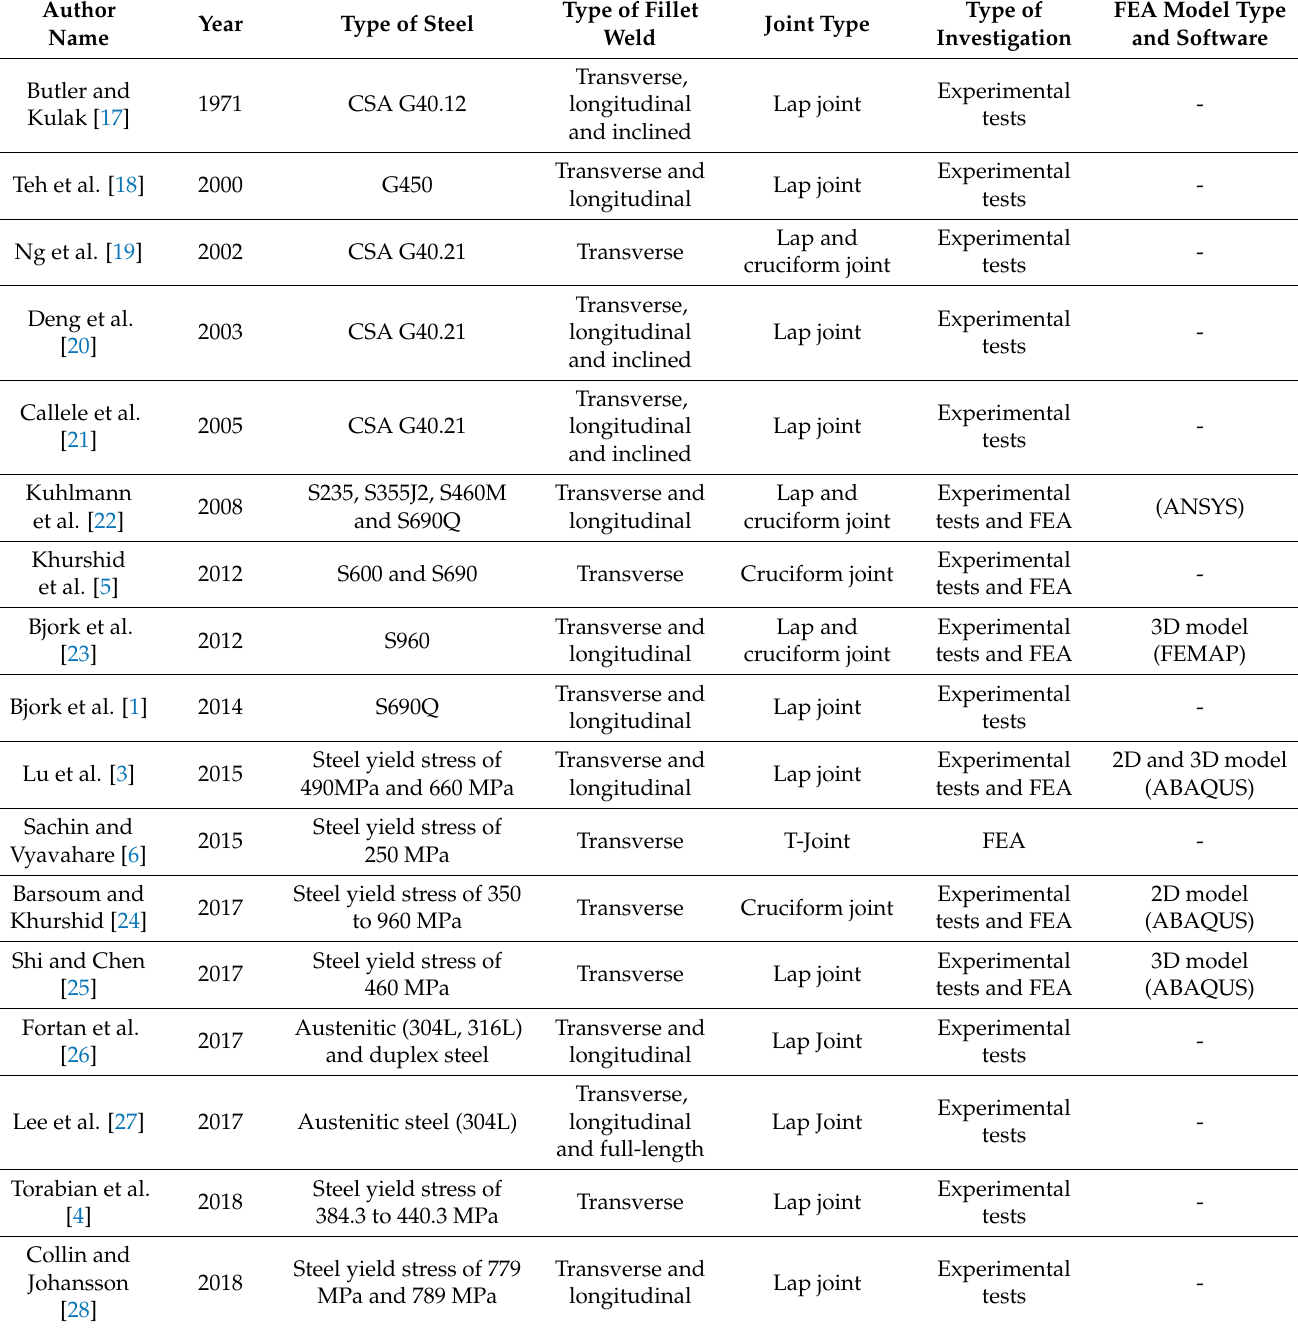
Table 1. Fillet welded joints under static